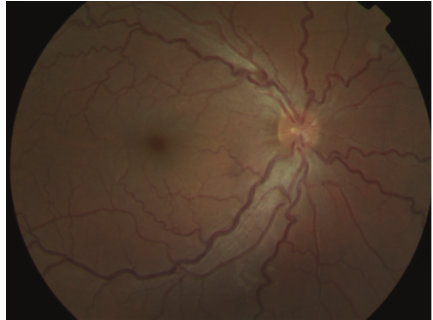
Figure 3: Retinal vascular tortuosity with normal optic